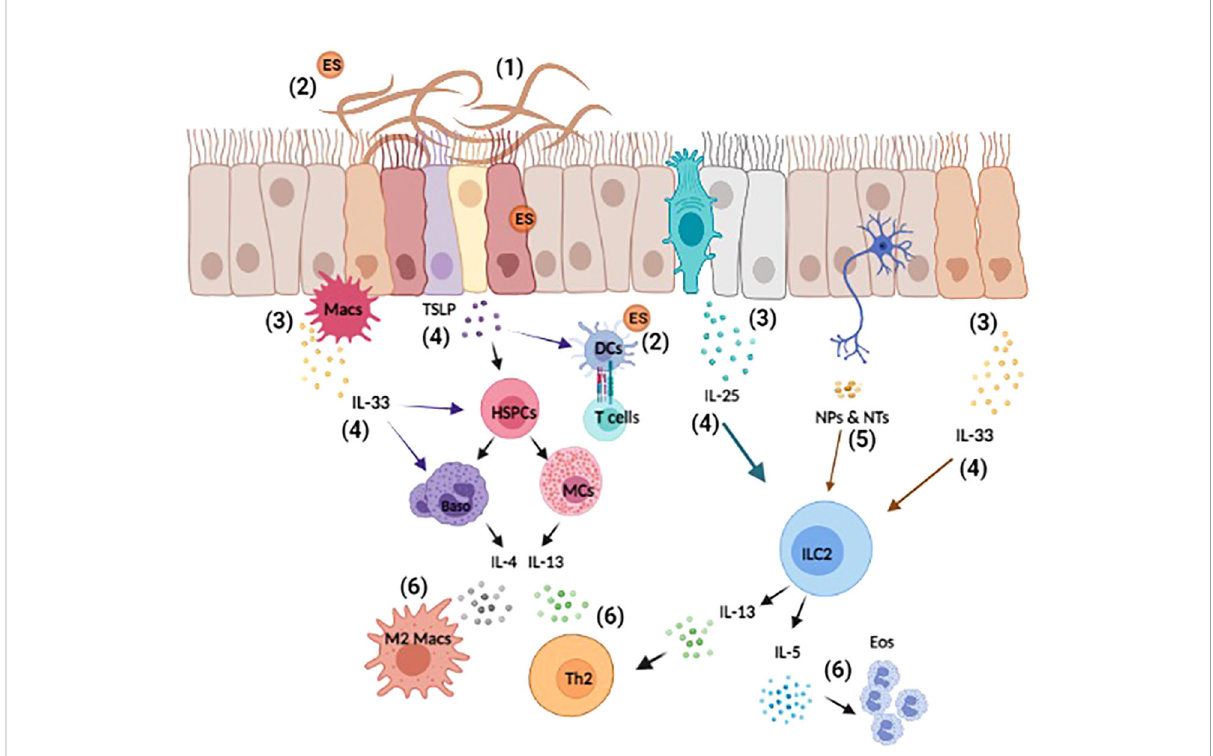
FIGURE 1 Overview of helminth-induced innate immune responses. Upon invasion, helminths cause substantial tissue damage as they burrow through various barriers and organs, such as the lungs, gut, and skin (1). Helminth also release excretory-secretory (ES) products that can act both locally and systemically (2). The damage-associated and helminth-derived signals promote the production of cytokine alarmins (IL-25, IL-33, and TSLP) from both hematopoietic and non-hematopoietic cells, such as macrophages (Macs) and epithelial cells (3). These early events drive the activation and expansion of innate immune cells, hematopoietic stem/progenitor (HSPCs), mast cells (MCs), basophils (Baso), dendritic cells (DCs), and ILC2s etc. (4). Moreover, innervating neurons can respond to helminth-derived signals by producing neuropeptides (NPs) and neurotransmitters (NTs) that directly in fl uence immune cell activation and regulate in fl ammation (5). Collectively, these events induce the production of the type 2 cytokines IL-4, IL-5, and IL-13 that promote the polarization of type 2 T helper (T H 2), the induction of M2 macrophages and eosinophilia (6). Reviewed in (9, 23, 41 –